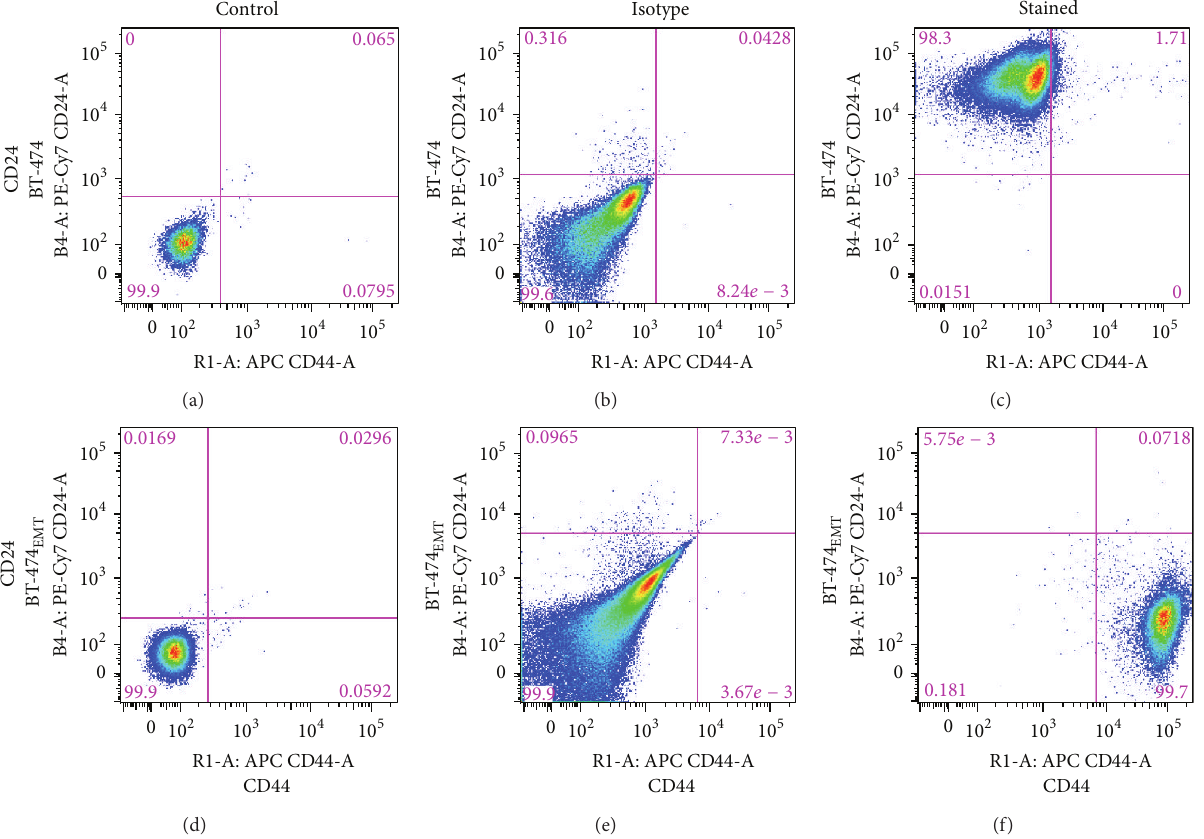
Figure 5: Flow cytometry data for the BT-474 and BT-47 4 cells demonstrates appropriate CD44 expression for the studies. The numbers EMT in the corner of each quadrant are the percentage of positive cells within the quadrant. (a) BT-474 unstained control, (b) BT-474 isotype control, (c) BT-474 stained cells with CD44, Alexa Fluor 647, and CD24, PE-Cy7. BT-474 cells are CD4 4 low /CD2 4 high . These cells served as the unstained control, (e) BT-47 4 isotype control, negative control for CD44 targeting, because they lack CD44 expression. (d) BT-47 4 EMT EMT stained cells with CD44, Alexa Fluor 647, and CD24, PE-Cy7. BT-47 4 cells are CD44 + /CD2 4 low . These cells were tested to (f) BT-47 4 EMT EMT investigate CD44 targeting, as they have high CD44